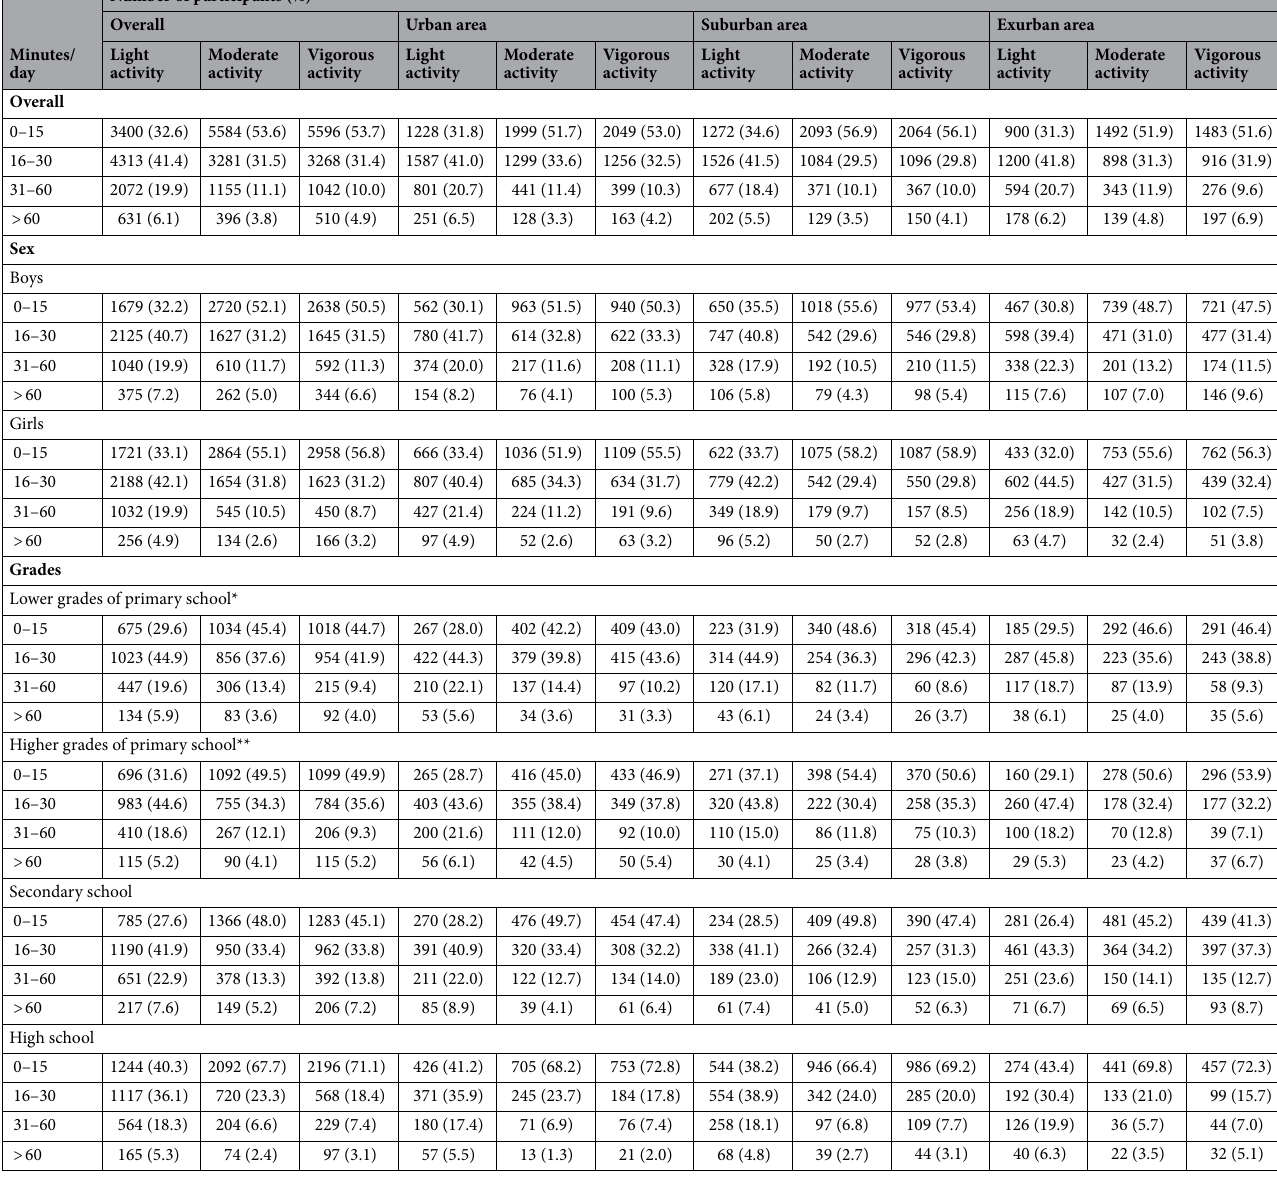
Table 2. Durations of three types of student’s physical activities during the COVID-19 pandemic. All data are presented as frequency and its percentage. a Lower grades of primary school: grades 1st to 3rd in